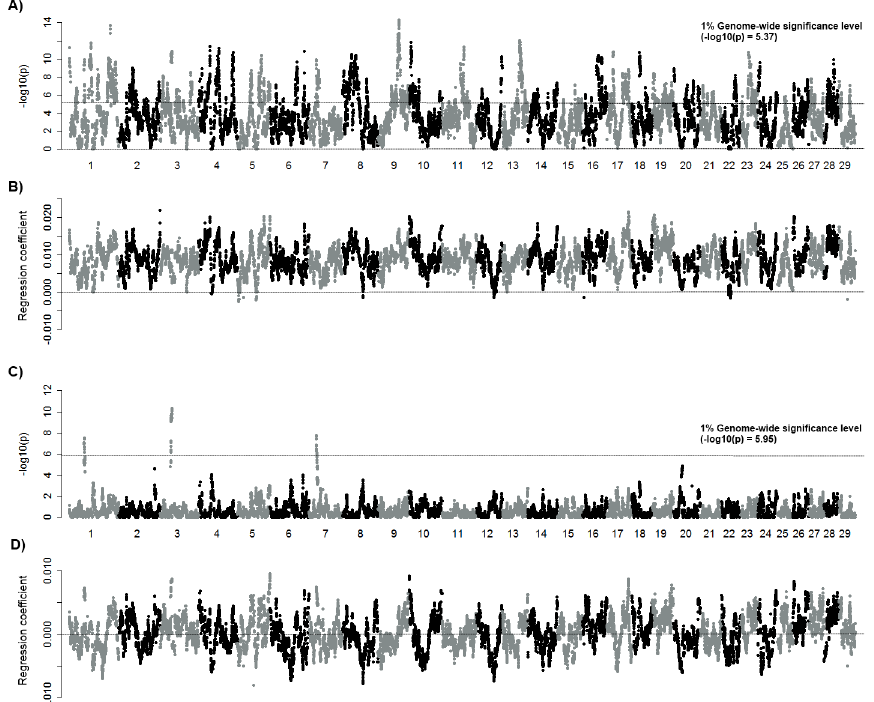
Fig 2. Genome-wide associations of ROH and F . Associations of ROH-FPED (-log 10 p) are plotted against each SNP locus across the genome (A). The y axis (B) represent the effect (slope) of ROH-FPED association and a dotted line indicates the effect = 0 (B). Genome-wide suggestive level is – log 10 p = 4.3, and the significant threshold ( – log 10 p = 5.4) is shown with dotted line (A). PCA based adjusted associations between ROH and FPED (C) and its effect (D) are plotted. A dotted line displays genome-wide significance level